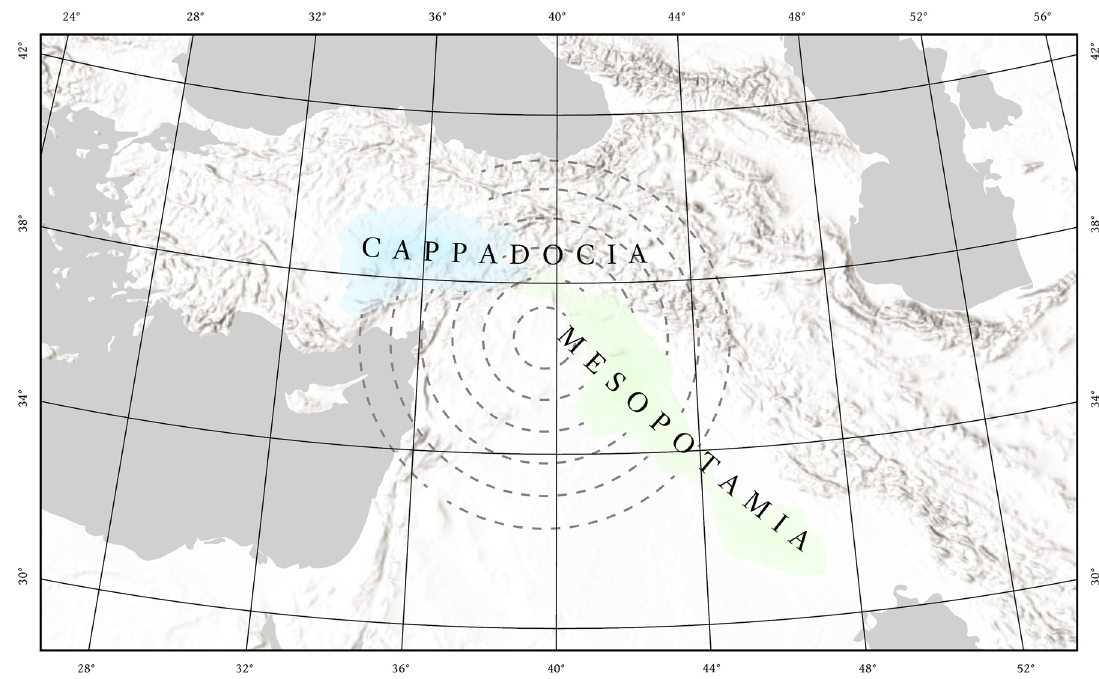
Figure 4: Search area for a region between Macedonia and